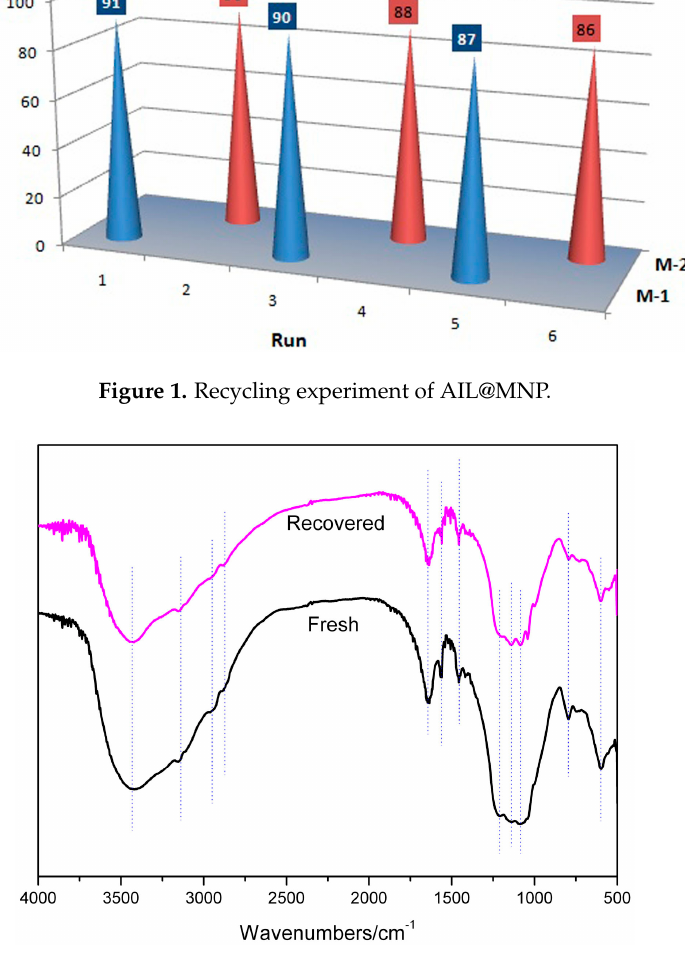
Figure 2. FT ‐ IR spectra of the recovered catalyst and fresh catalyst.